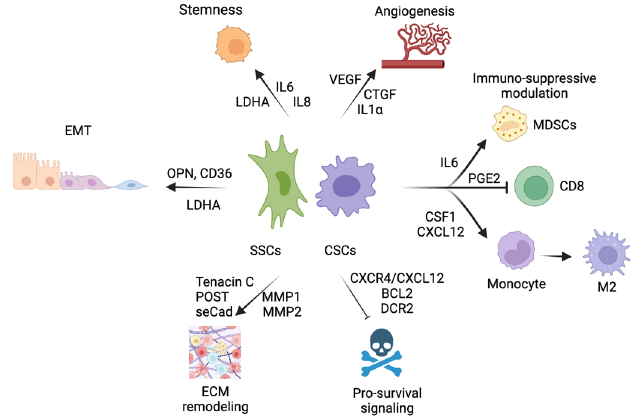
Figure 2. Summary of the factors secreted by senescent cancer cells and stromal senescent cells in each feature required for cell invasion. SSCs (senescent stromal cells); CSCs (cancer senescent cells); seCad (soluble E-cadherin).